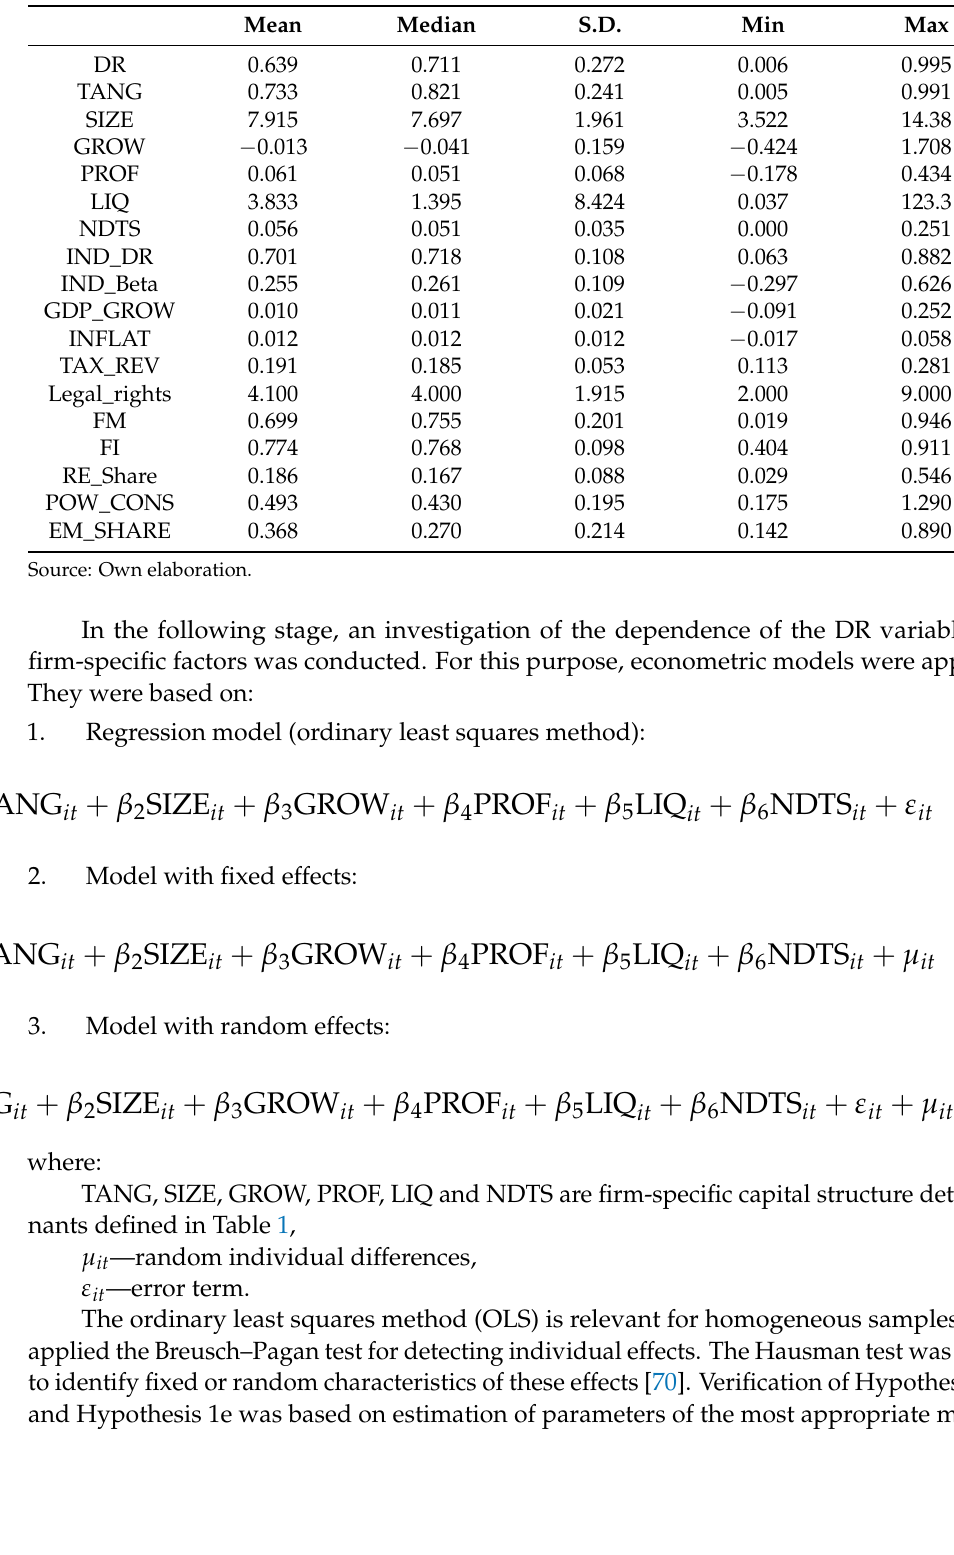
Table 2. Descriptive statistics of all